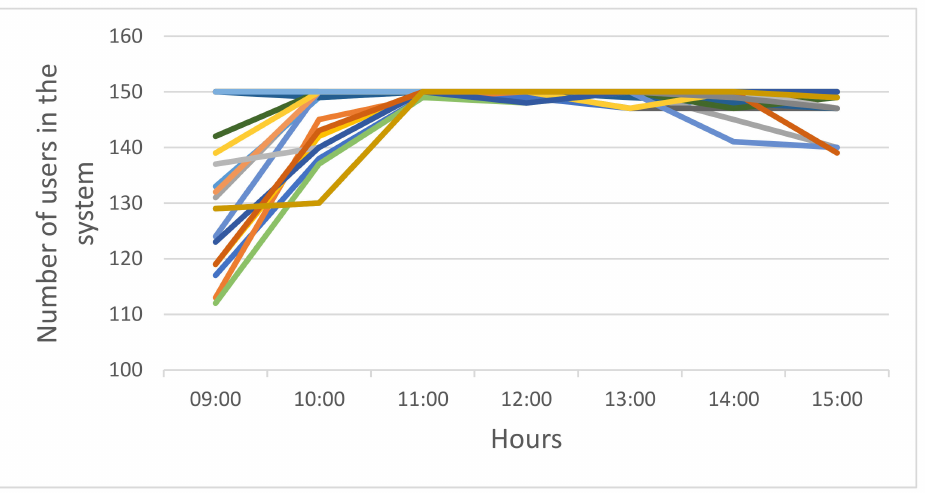
Figure 2. Number of users in the case study system over time. Each color represents a different